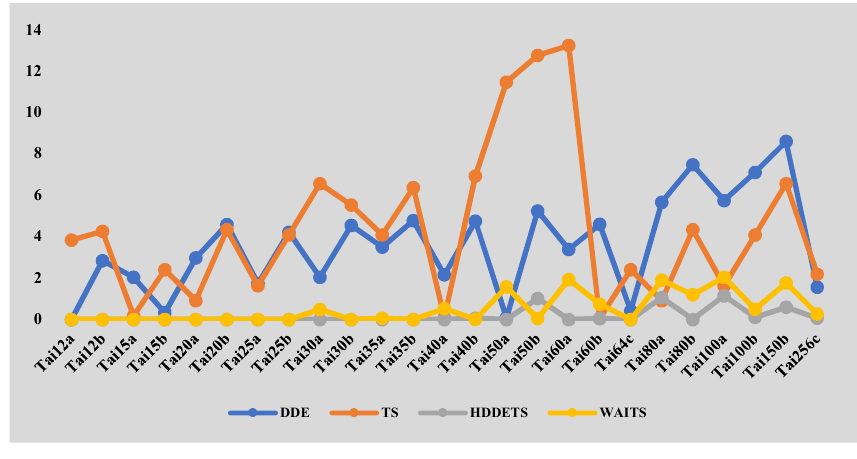
Fig. 9 . Comparison on instance